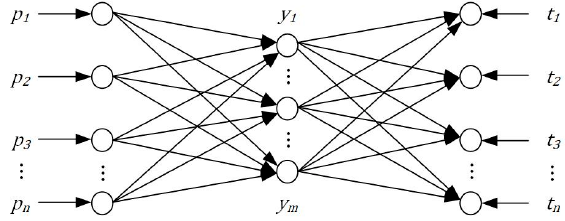
Figure 10. An artificial neural network for error detection.